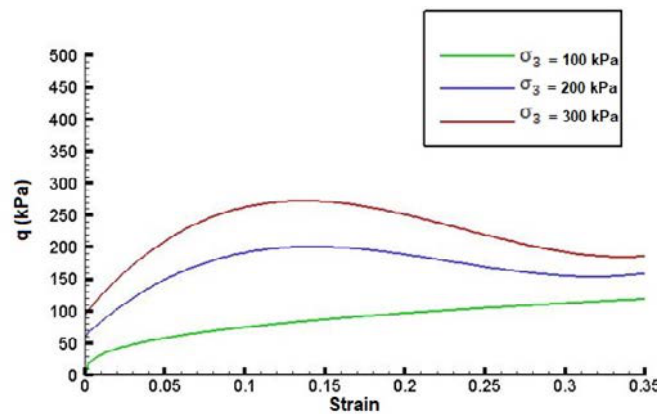
Fig. 3: Stress-strain diagram for MSW at Young’s moduli of 5, 10, and 15 MPa Fig. 3: Stress‐strain diagram for MSW at Young’s moduli of 5, 10, and 15 MPa